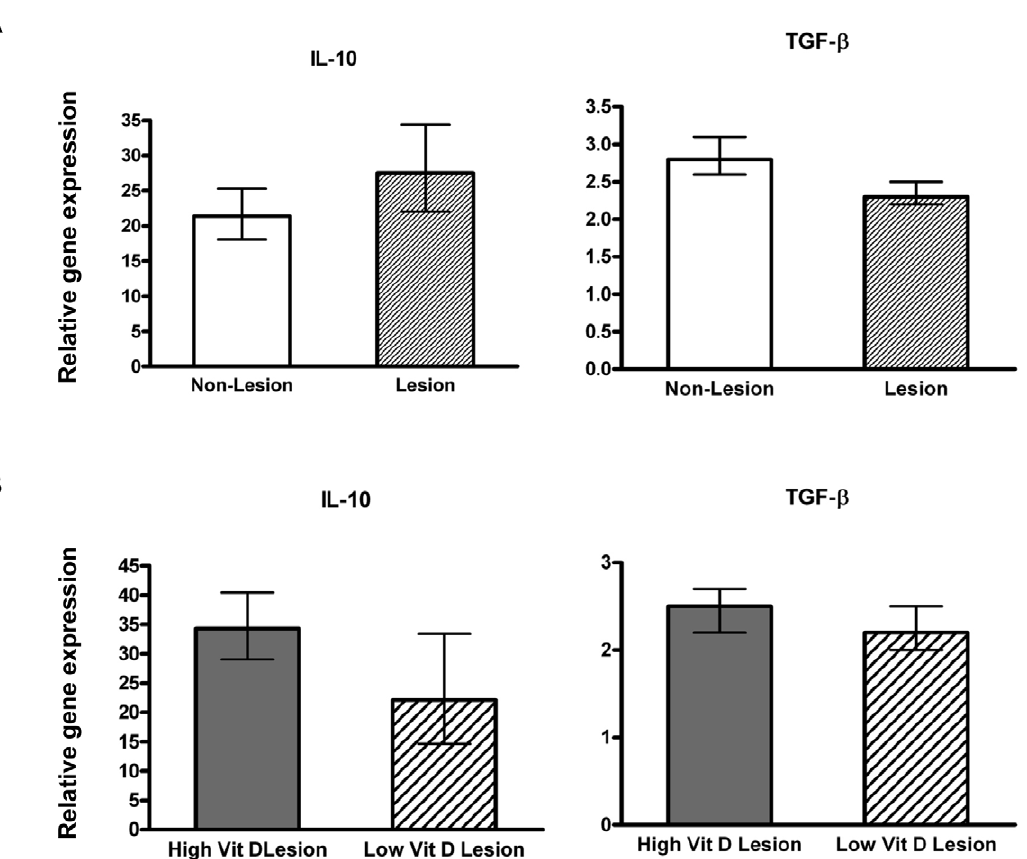
Figure 7. Anti-inflammatory cytokine gene expression levels in lung tissues of calves following bovine RSV experimental infection. ( A ) Anti-inflammatory cytokine mRNA levels in lesioned or non-lesioned lung samples from bovine RSV-infected calves irrespective of vitamin D treatment (n=16). ( B ) Anti-inflammatory cytokine mRNA levels in lesioned lung samples from bovine RSV-infected calves with low (n=8) or high (n=8) circulating 25(OH)D 3 levels. The amount of each target gene was determined by quantitative real-time PCR with normalization to RPS9. DD Ct values 6 SE were transformed (2 2 DD Ct ) and data are presented as the target gene expression relative to control lung samples (n=4). Statistical analysis was performed using Student’s t-test. DD Ct values were used in the analysis of relative gene expression.